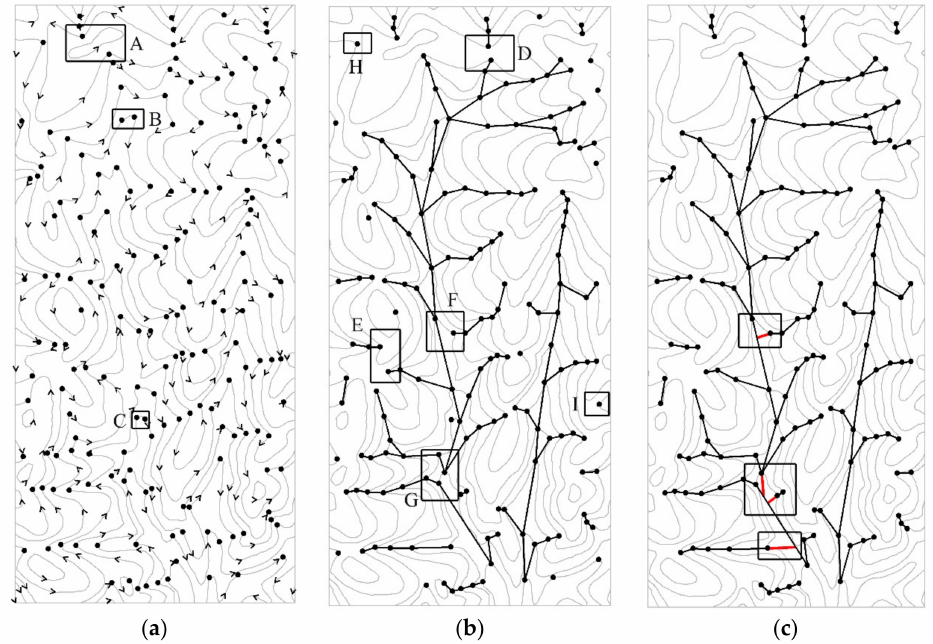
Figure 10. Comparison between the valley points extracted before and after contour direction adjustments: ( a ) valley points extracted prior to direction adjustment, ( b ) valley points extracted after direction adjustments, and ( c ) valley lines compensated by the slope extension